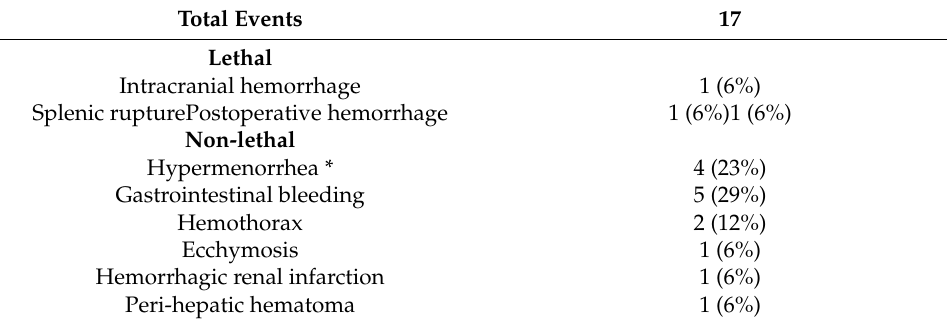
Table 3. Bleeding events post transplantation, n (%).